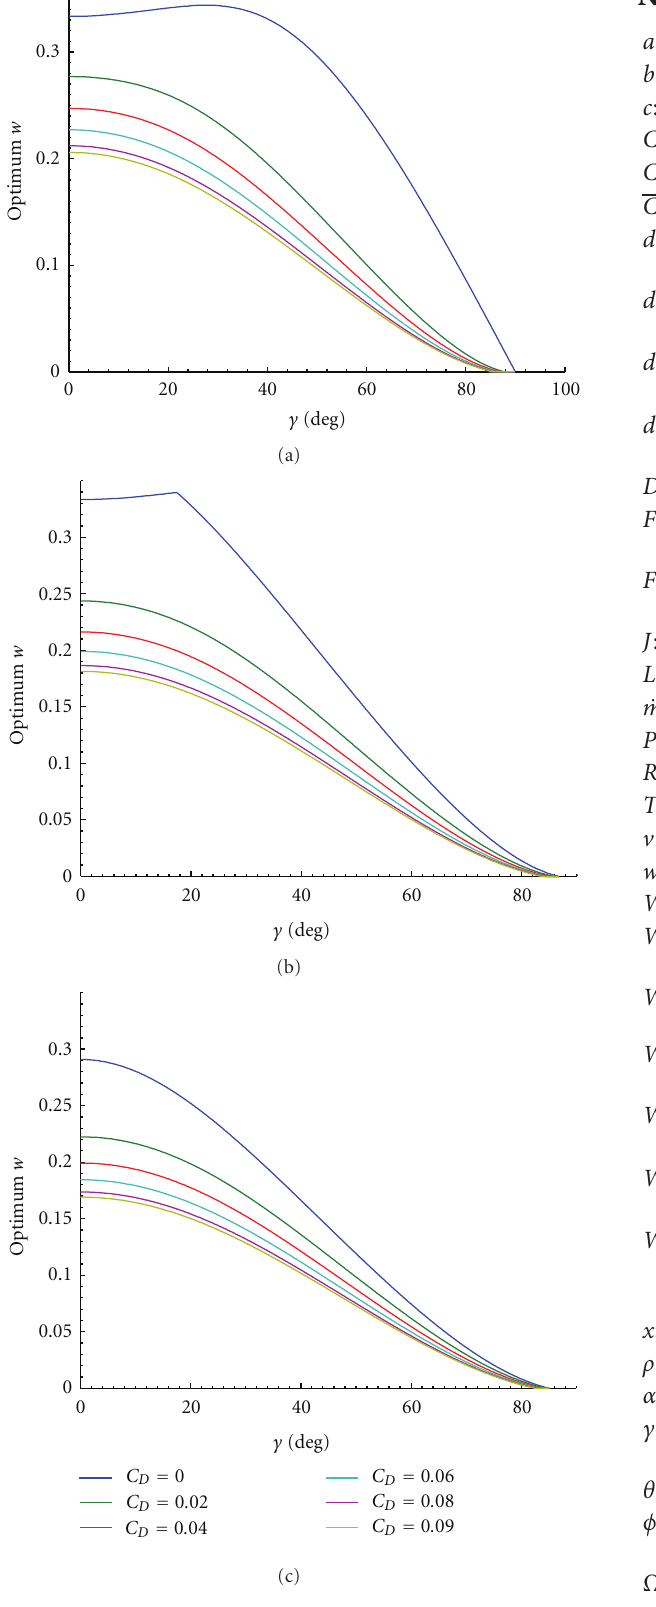
Figure 22: (a) Optimum w versus γ for θ = 0 ◦ , (b) Optimum w versus γ for θ = 2 ◦ , and (c) Optimum w versus γ for θ = 3 ◦